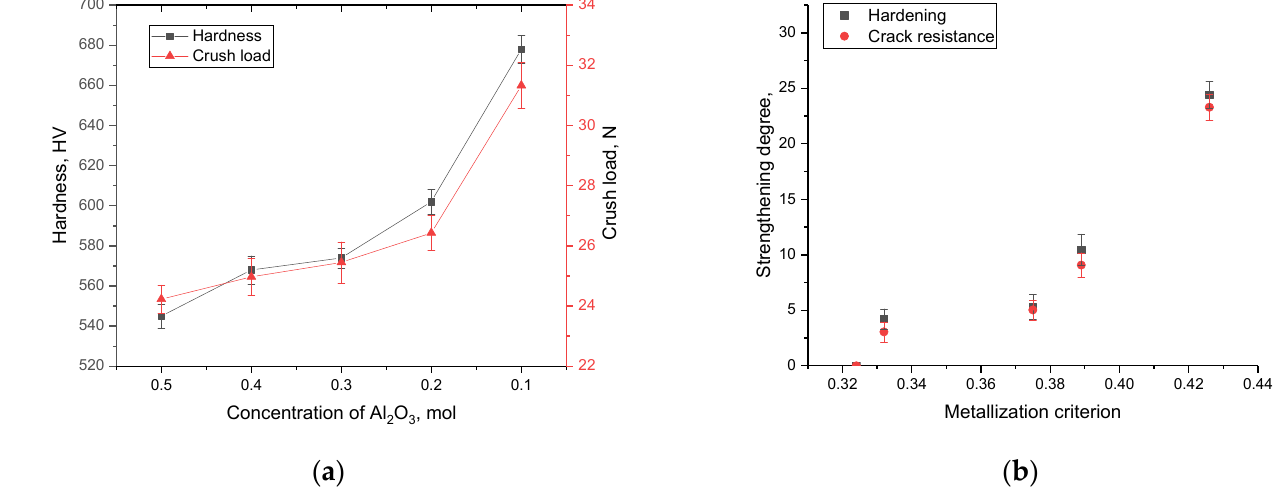
Figure 12. ( a ) Dependence of the change in the strength characteristics of (1 − x)Si 3 N 4 -xAl 2 O 3 ceramics with variation of the components; ( b ) Dependence of the change in hardening characteristics on the criterion of metallization of ceramics.